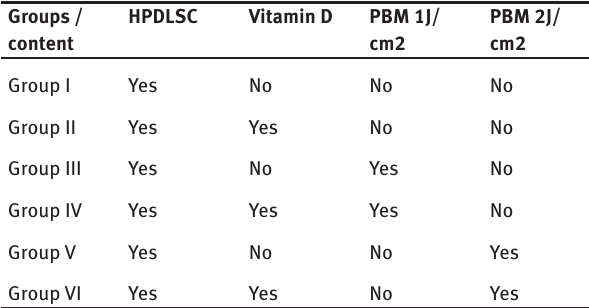
Table 1: showing study design and contents for each culture well group. Groups